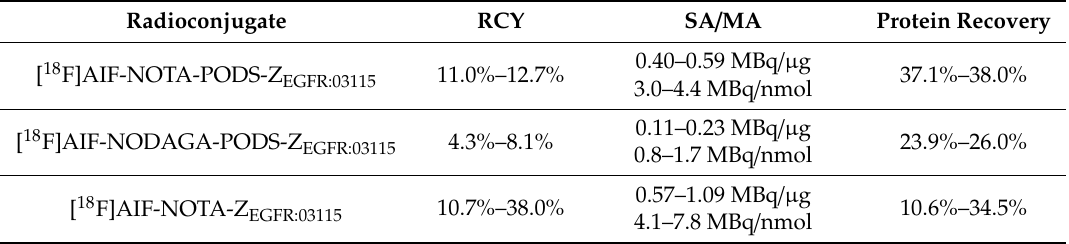
Table 1. Summary of radiolabeling reactions. Radiochemical yields (RCY) and apparent specific (SA) and molar activities (MA) are decay corrected.